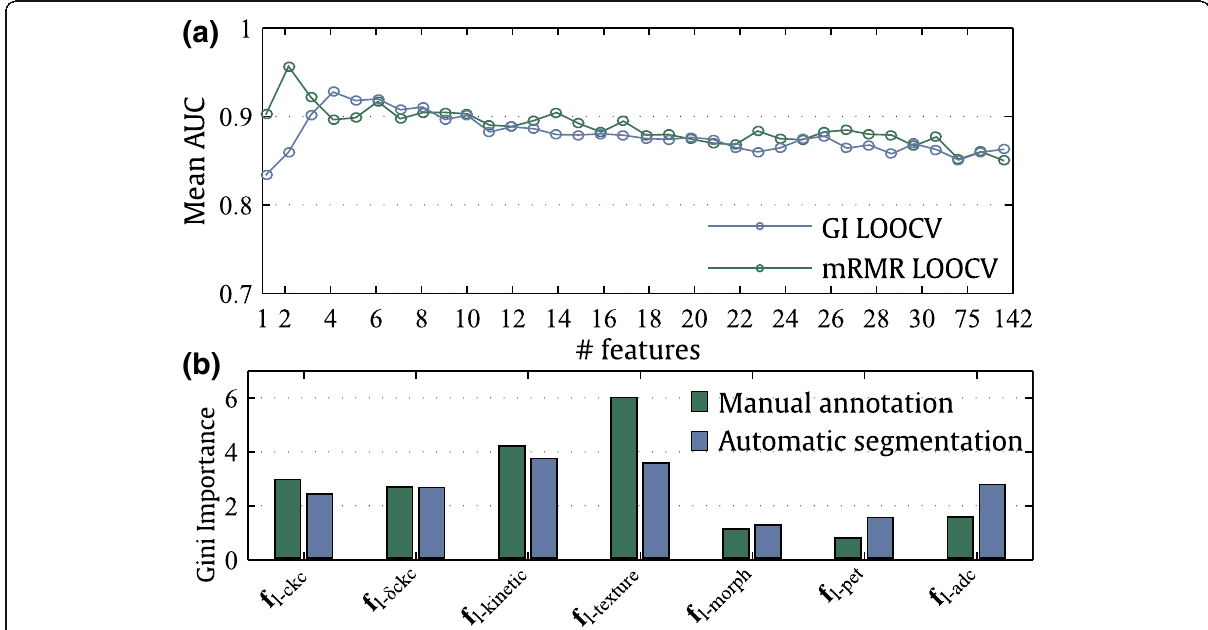
Fig. 6 Feature ranking and its influence on classification performance. a Mean ROC-AUC using an increasing number of top-ranked features according to GI and mRMR ranking. b GI ranking showing the top-ranked classification features of each feature-group, computed from manual annotations (green) and automatic segmentations